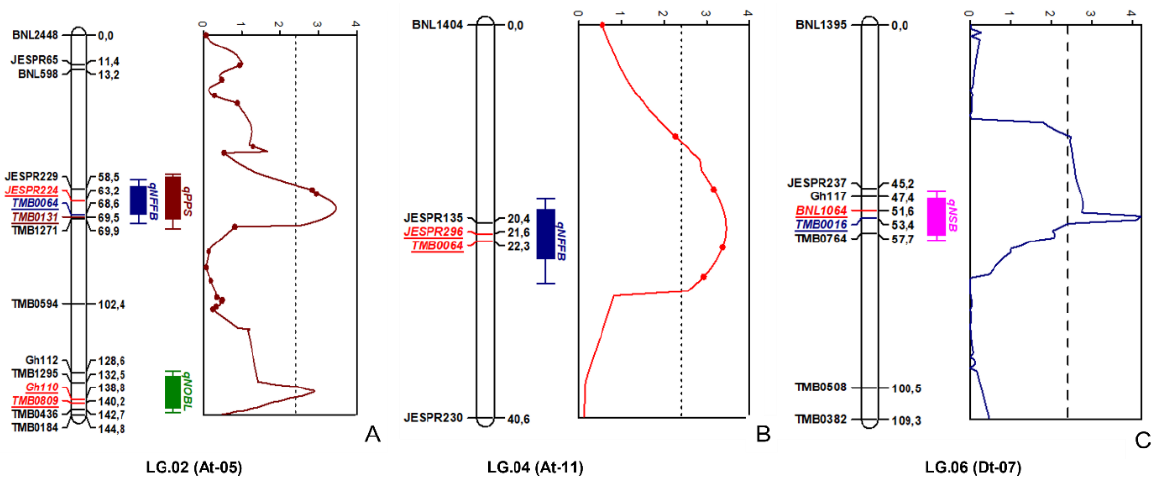
Figure 8. QTL maps of the F 2 population showing the location of QTLs for photoperiodic sensitivity. ( A ) LG.02 (At-05), ( B ) LG.04 (At-11), and ( C ) LG.02 (At-05). The QTLs: qPPS — photoperiod